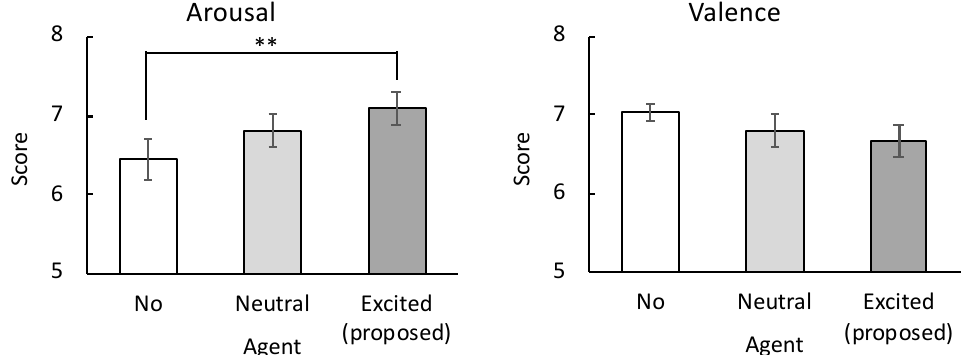
Figure 9. Mean subjective ratings (with standard error bars) of excitement (left image) and empathy (right image) for the agents by the participants, rated on the affect grid. ** p <